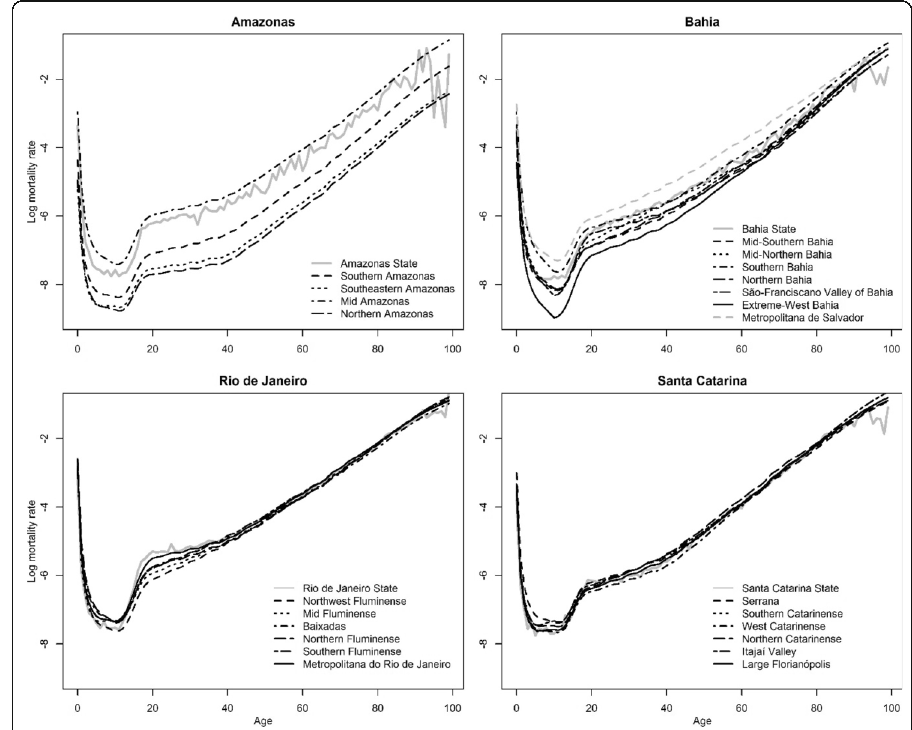
Fig. 1 Observed and smoothed age-specific mortality rates according to selected mesoregions in Brazil, males, 1980 – 1991. Source: IBGE (1980, 1991, and 2000) and DATASUS